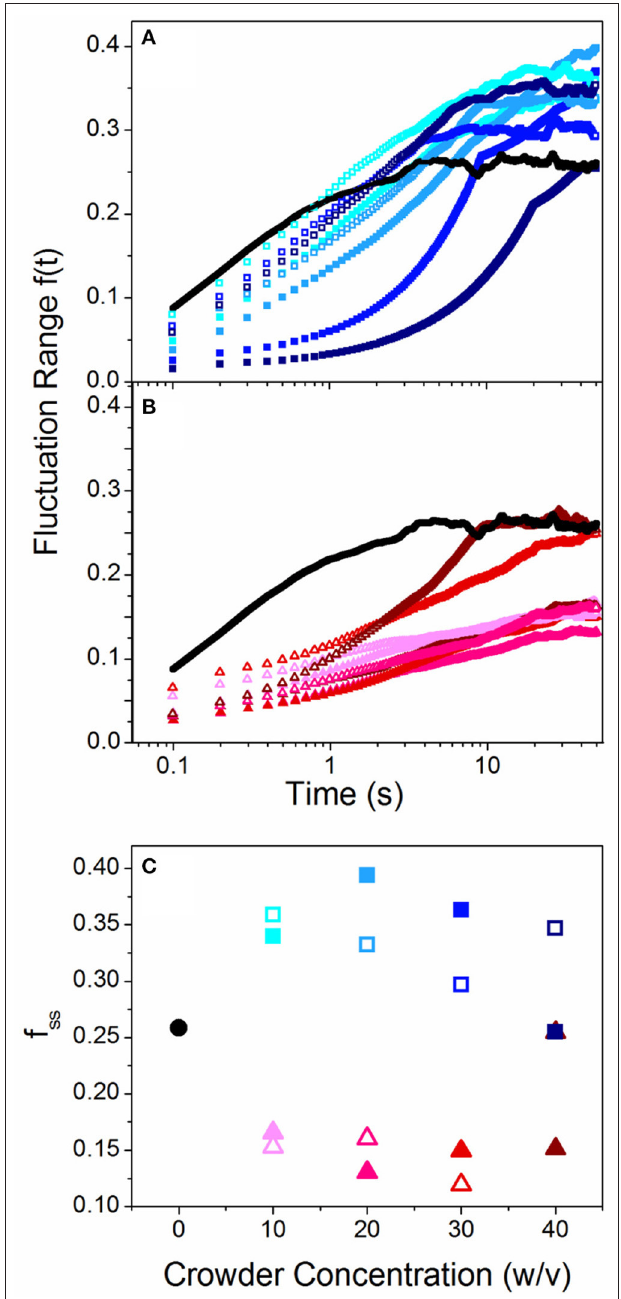
FIGURE 2 | Crowded DNA molecules fluctuate over a range of different conformational states over time with a steady state fluctuation range that depends on crowder structure. (A,B) Fluctuation range, f(t) , as a function of time for linear (A) and branched (B) crowders compared to buffer conditions (black lines). Open and closed symbols signify small (10 kDa) and large ( ∼ 500 kDa) crowders and color shade increases with increasing crowder concentrations (10, 20, 30, 40% w/v). (C) Steady-state fluctuation range, f ss [i.e. the terminal plateau values of f(t) ], vs. crowder concentration for linear (squares) and branched (triangles) crowders. As shown, linear crowders increase f ss from the buffer condition value, while branched crowders reduce f ss . These effects are largely independent of crowder size and